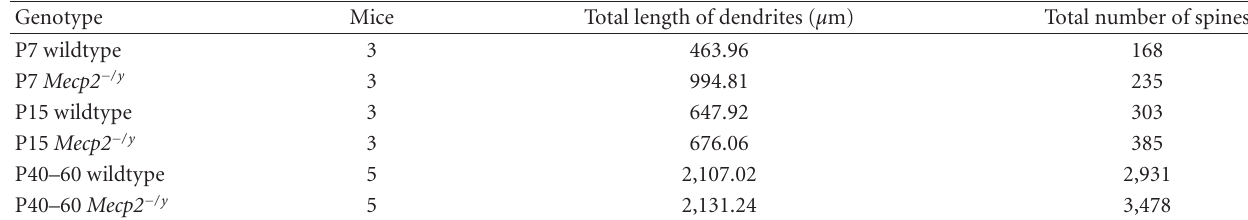
Table 1: Total number of mice, length of dendrites, and individual dendritic spines counted and measured in the quantitative